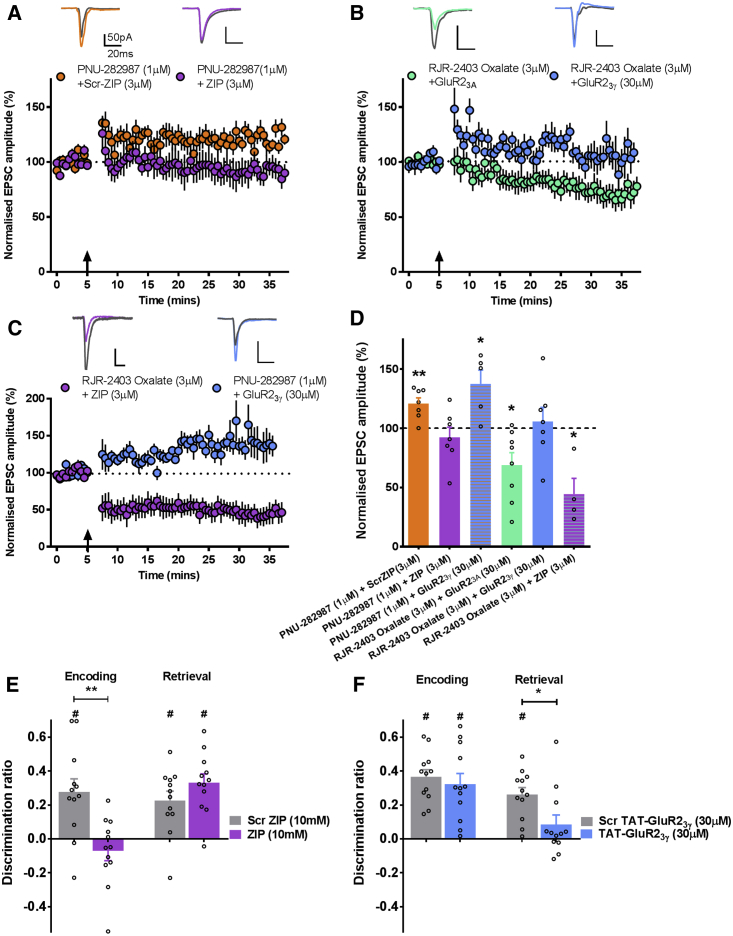
Disrupting Expression of LTP or LTD Blocks α7-Induced LTP and α4β2-Induced LTD and Blocks Associative Memory Encoding and Retrieval, Respectively(A) ZIP (n = 7), but not Scr-ZIP (n = 7), prevented STDP/PNU-282987 induction of LTP.(B) GluR23γ (n = 7), but not GluR23A (n = 8), prevented STDP/DHβE induction of LTD.(C) α7 nAChR LTP was not blocked by GluR23γ (n = 5), and α4β2 nAChR LTD was not blocked by ZIP (n = 4). Representative traces shown from baseline and the last 5 min of the experiment.(D) Summary of normalized EPSC amplitudes recorded in the final 5 min of each experiment.(E) ZIP impaired OiP memory when infused before the sample phase (n = 12), but not the test phase (n = 12).(F) TAT-GluR23γ impaired OiP when infused before the test phase (n = 12), but not the sample phase (n = 12). The average discrimination following two trials with TAT-GluR23γ/Scr TAT-GluR23γ infusion before the test phase is shown.Data are presented as mean ± SEM (∗p < 0.05, ∗∗p < 0.01 paired t test; #p < 0.05 one-sample t test against 0). See also Table S3.